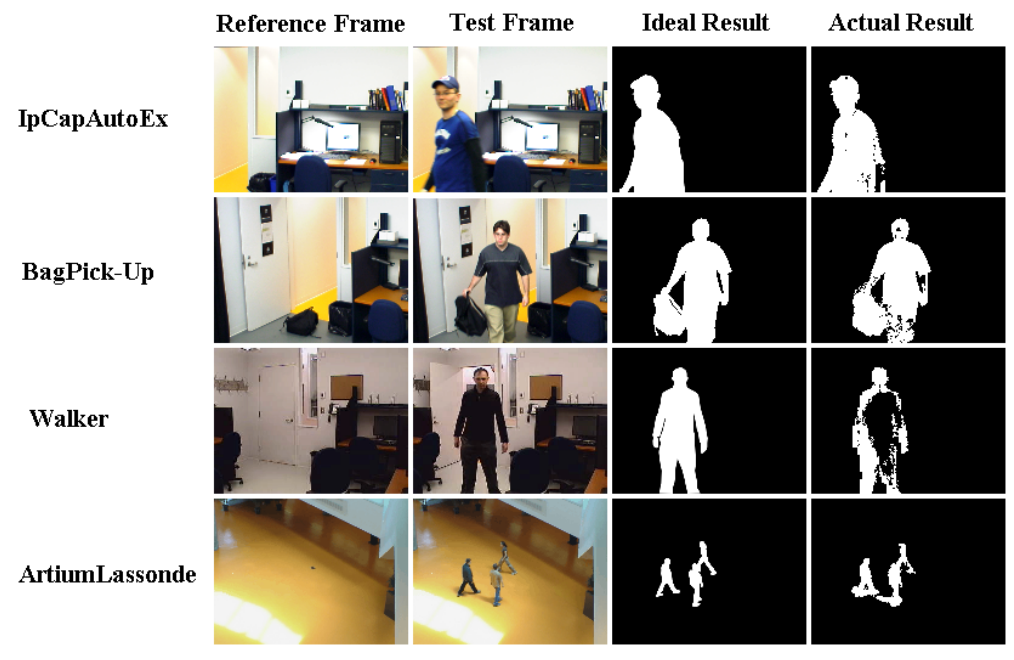
Figure 12. Detection results of the proposed method for our